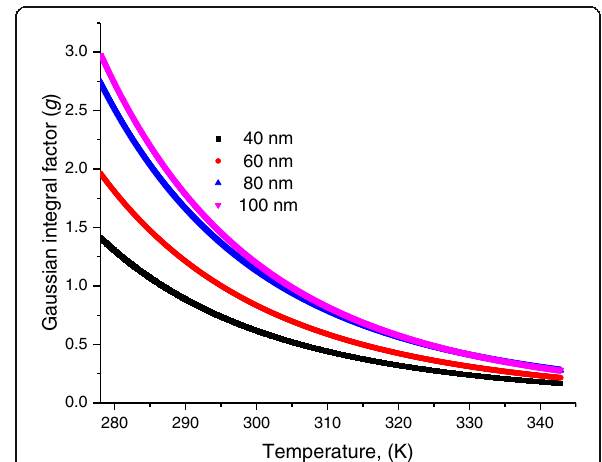
Fig. 9 Dependence of the Gaussian factor ( g ) as a function of temperature for different DNA lengths